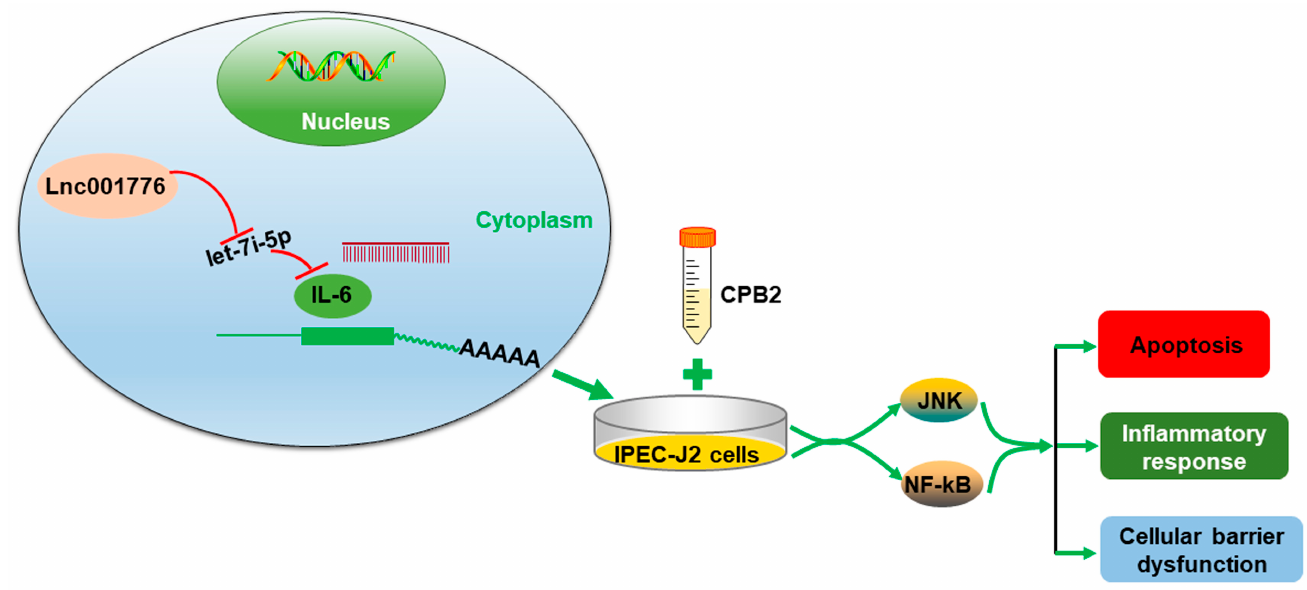
Figure 12. lnc001776/ ssc-let-7i-5p / IL-6 regulatory axis regulates CPB2 toxin-induced IPEC-J2 cell damage through the JNK/NF-kB pathway. lnc001776 upregulates IL-6 expression through adsorp- tion of ssc-ssc-let-7i-5p, activates the JNK/NF-kB pathway, stimulates apoptosis and in fl ammatory responses, disrupts intestinal epithelial barrier function and, ultimately, exacerbates CPB2 toxin-induced IPEC-J2 cell damage.